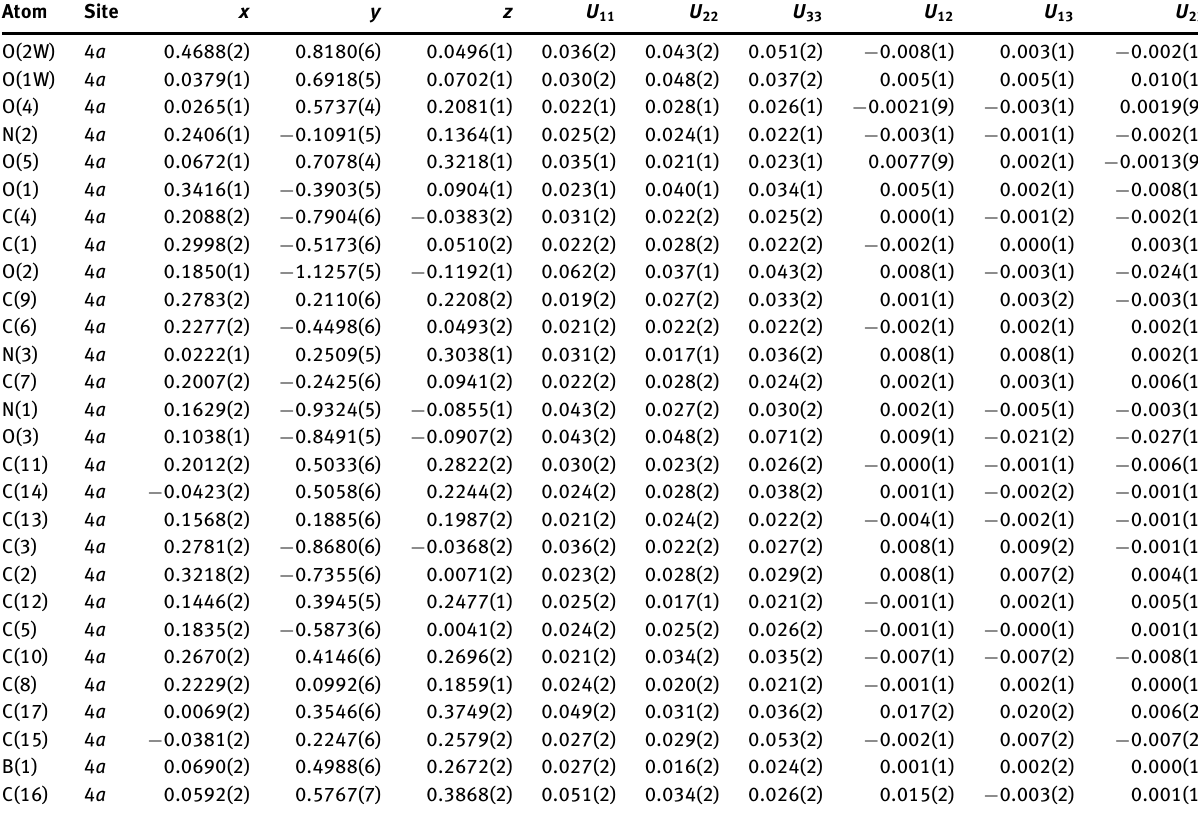
Table 3: Atomic coordinates and displacement parameters (in Å 2